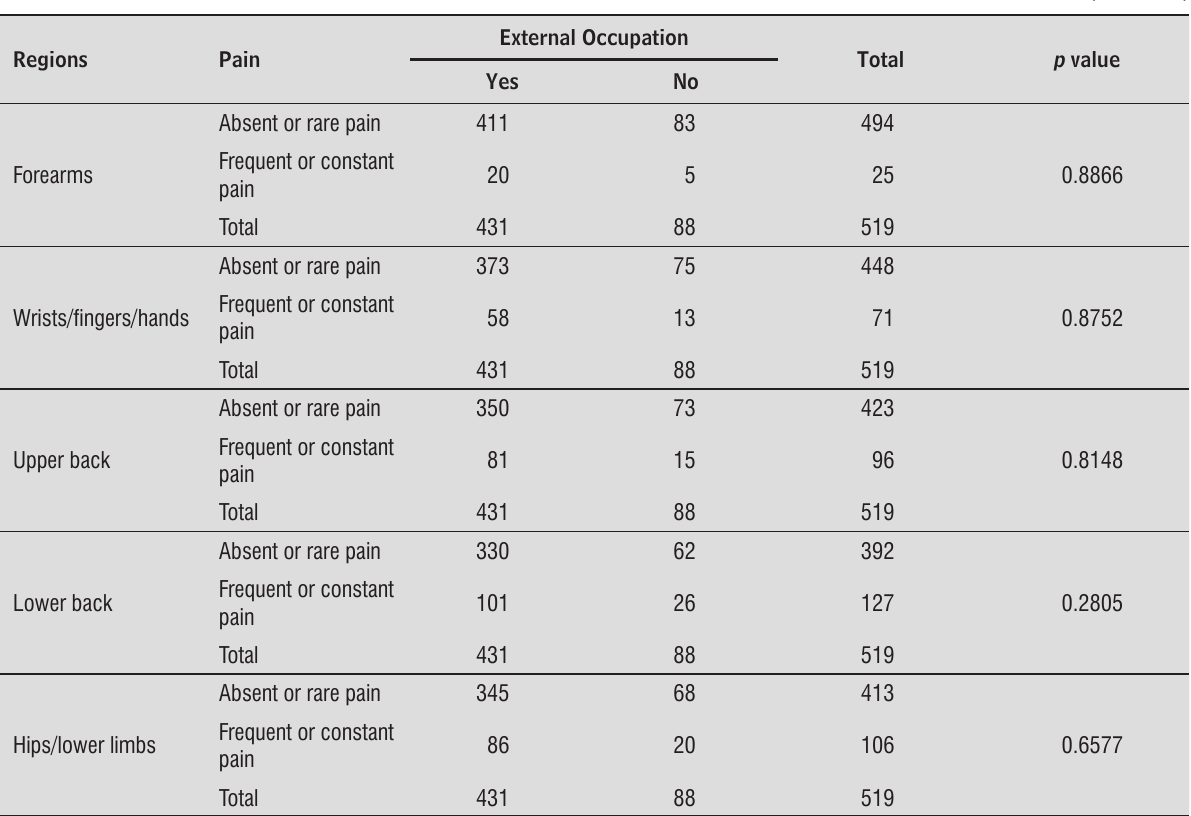
Table 3 - Presence of pain and performance of other professional activities of Unifal-MG staff (Campus I, Alfenas, Minas Gerais,